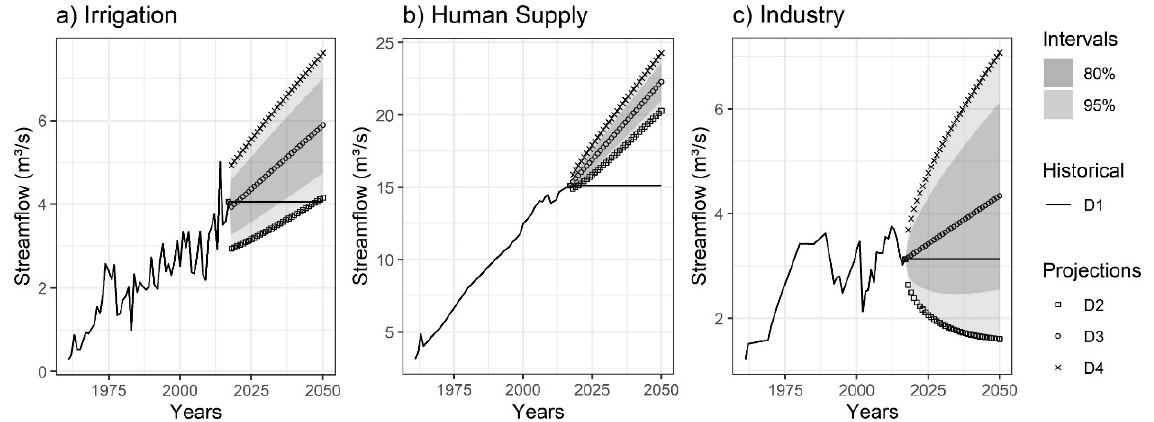
Figure 14. Scenarios of the projections of annual consumptive demands on the Retiro Baixo reservoir using the ETS model for the period 2018 to 2050.